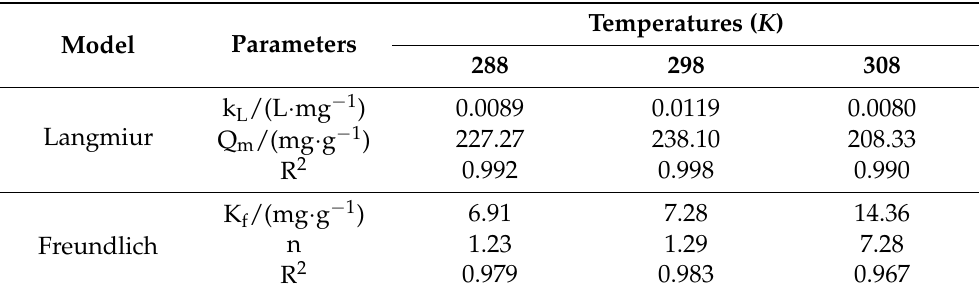
Table 3. Correlation coefficients and parameters of AQ2S adsorption by the Langmuir and Freudlich model.